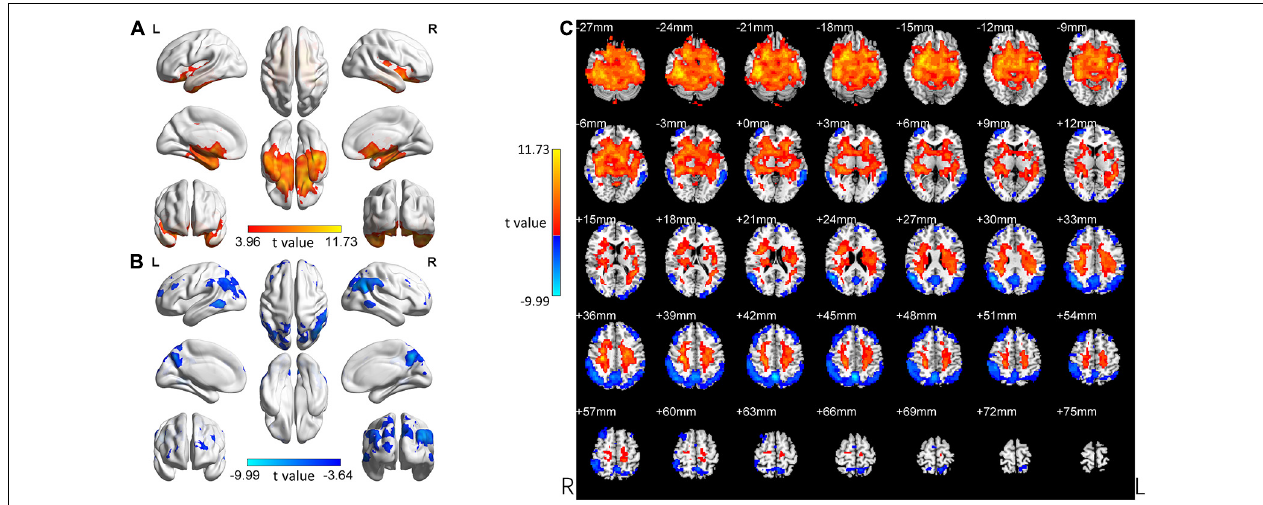
FIGURE 3 | Changed ReHo in the aMCI group compared with the HC group. (A) The brain regions with increased ReHo in the aMCI group compared with the HC group. (B) The brain regions with decreased ReHo in the aMCI group compared with the HC group. (C) Brain regions with increased and decreased ReHo in the aMCI group compared with the HC group. Two-tailed t -test; FDR < 0.0005, k > 10 voxels. The color bars indicate t -values, blue color represents negative values and red color represents positive values. L, Left; R,